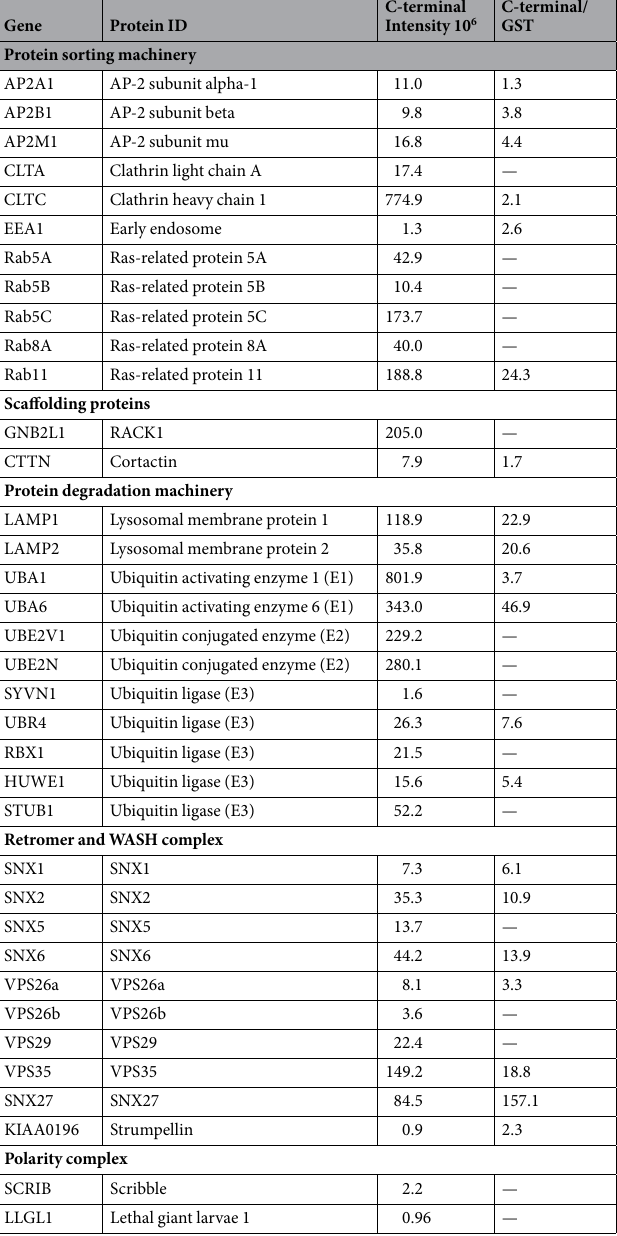
— Table 1. Putative binding candidates for NBCn1 C-terminal in MCF-7 cells. Putative binding candidates for NBCn1 C-terminal in MCF-7 cells. The NBCn1-C-tail tagged with GST was produced recombinantly in E. coli . MCF-7 cells were grown to 90% confluency and lysed. NBCn1-C-GST-bound beads were added to the lysates, with GST-only conjugated beads and MCF-7 cell lysates with no beads as control conditions. Proteins were isolated and prepared for mass spectrometry, and data analysed, as described in Materials and Methods. An independent experiment conducted in MCF-7 cells expressing p95HER2 yielded similar results. The values listed in the table are intensities in millions (10 6 ). A C-terminal/GST ratio was calculated based on intensities in the C-terminal pull- down and GST-pull-down. “–”, indicates no intensity measured for GST, thus no ratio